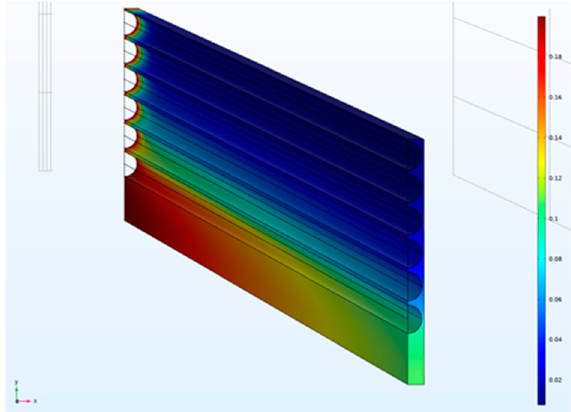
Figure 8. Simulation geometry and sample CO 2 mole fraction distribution for planar module with square configuration ( φ = 0.6, D/R f = 4.6). Concentration decreases from red to blue.